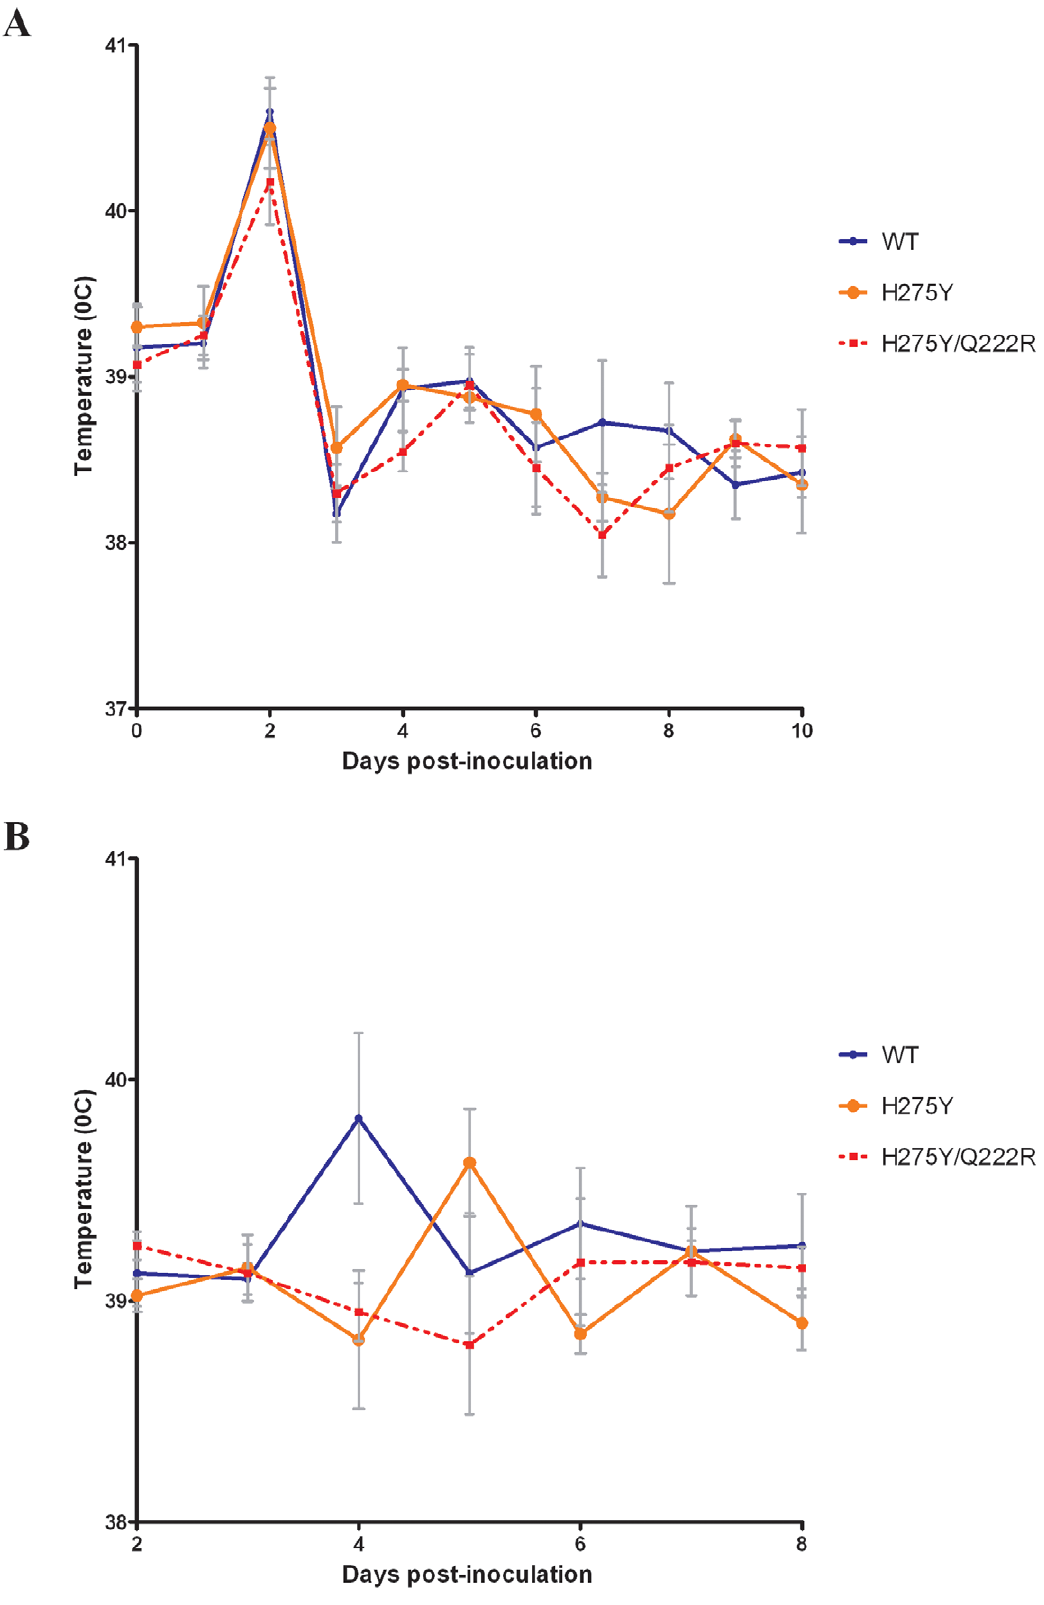
Figure 4. Body temperatures of infected and contact ferrets. Body temperatures were recorded by rectal thermometer during 10 days post- inoculation in groups of 4 index ferrets infected with 1.25 6 10 5 PFU of recombinant A/Brisbane/59/2007-like wild-type (WT) virus as well as H275Y and H275Y/Q222R mutants (A) and in groups of 4 naı¨ve ferrets that were placed in direct contact with index ferrets 24 h later (B).